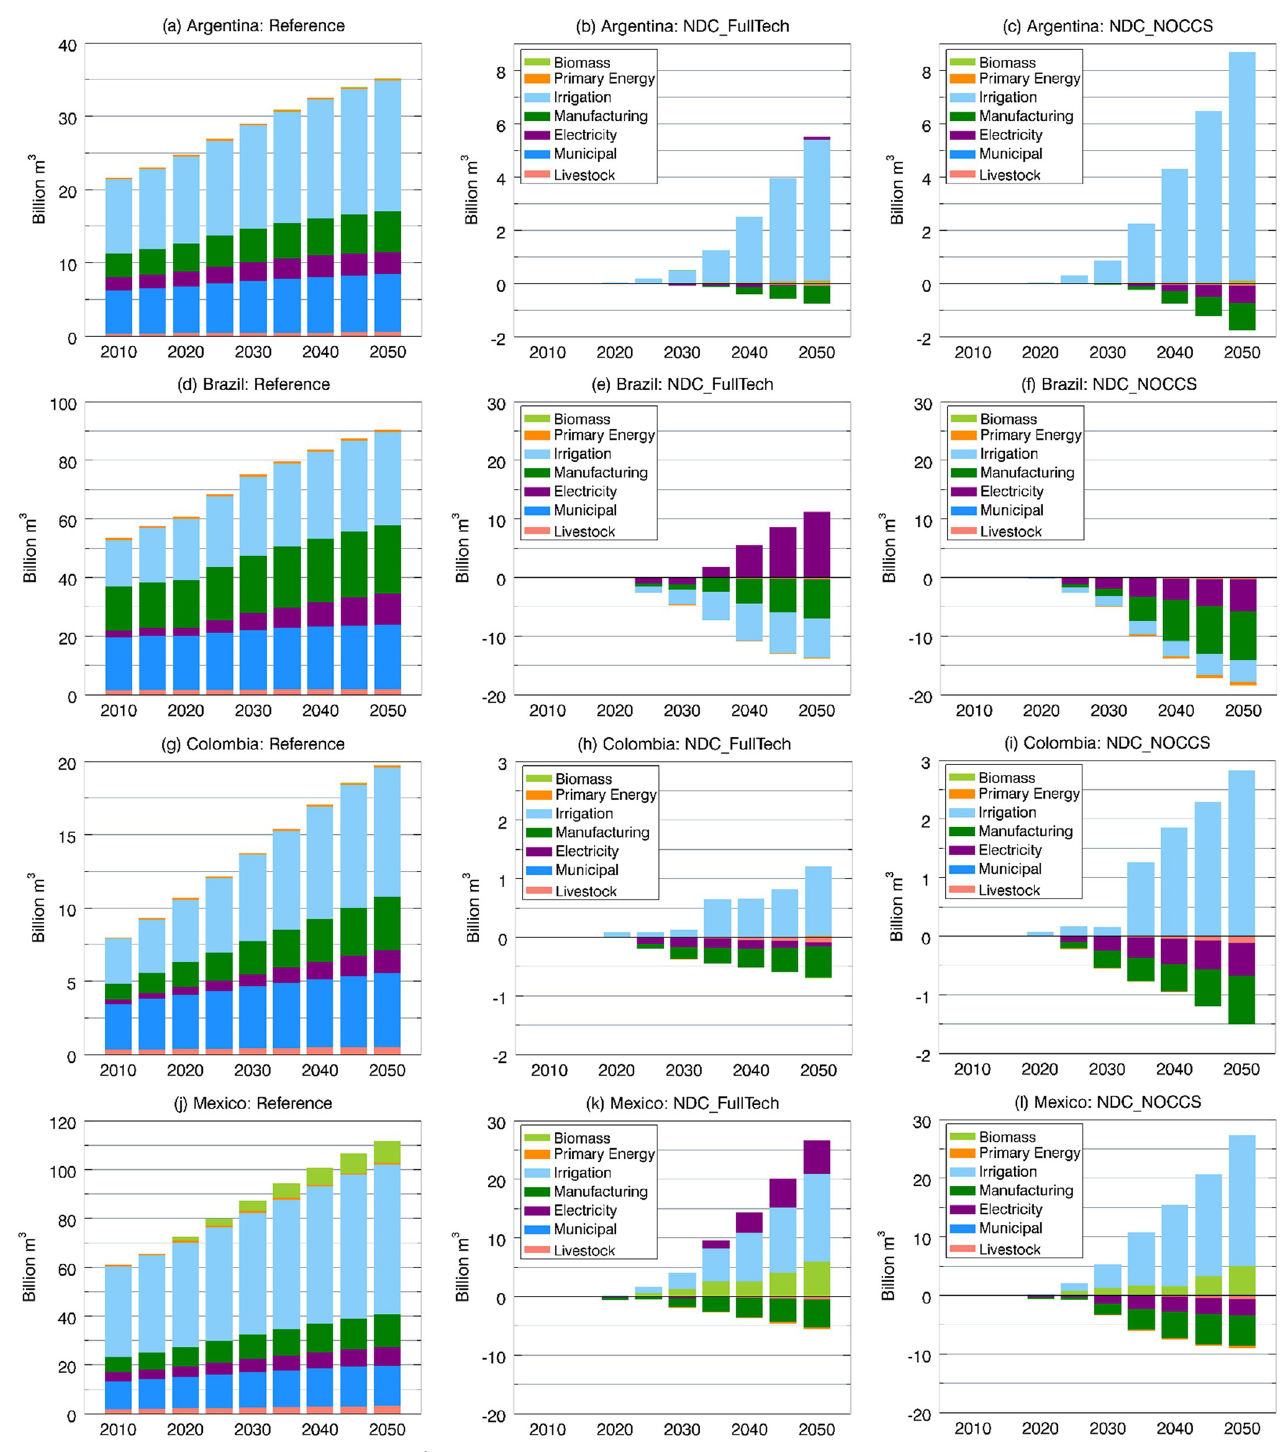
Fig 4. Total water withdrawals by sector (billion m 3 ) under the Reference ((A), (D), (G), and (G)). Water withdrawal differences between the NDC_FullTech and the reference pathways in (B) Argentina, (E) Brazil, (H) Colombia, and (K) Mexico. Water withdrawal differences between the NDC_NOCCS and the reference pathways in (C) Argentina, (F) Brazil, (I) Colombia, and (L) Mexico.